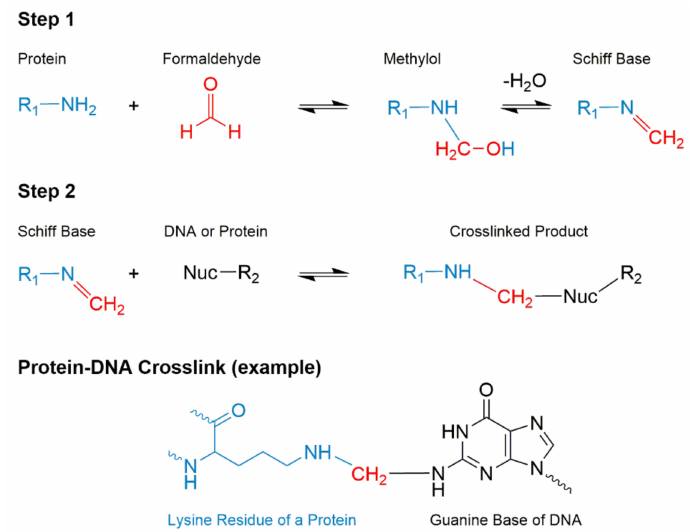
Figure 3. The reactions of formaldehyde mediated crosslinking of DNA and protein. Formaldehyde diffuses through tissue and reacts with a nucleophilic sites of protein and/or DNA base resulting in unstable intermediates of methylol and Schiff base. Then, a second nucleophile from inter- or intramolecular DNA or protein attacks the Schiff base resulting in a crosslinked complex. A specific example of a protein-DNA crosslink is shown. The atoms are color coded: cyan , protein; red , formaldehyde; and black , DNA. Reproduced with permission from [65]. Copyright ASBMB,